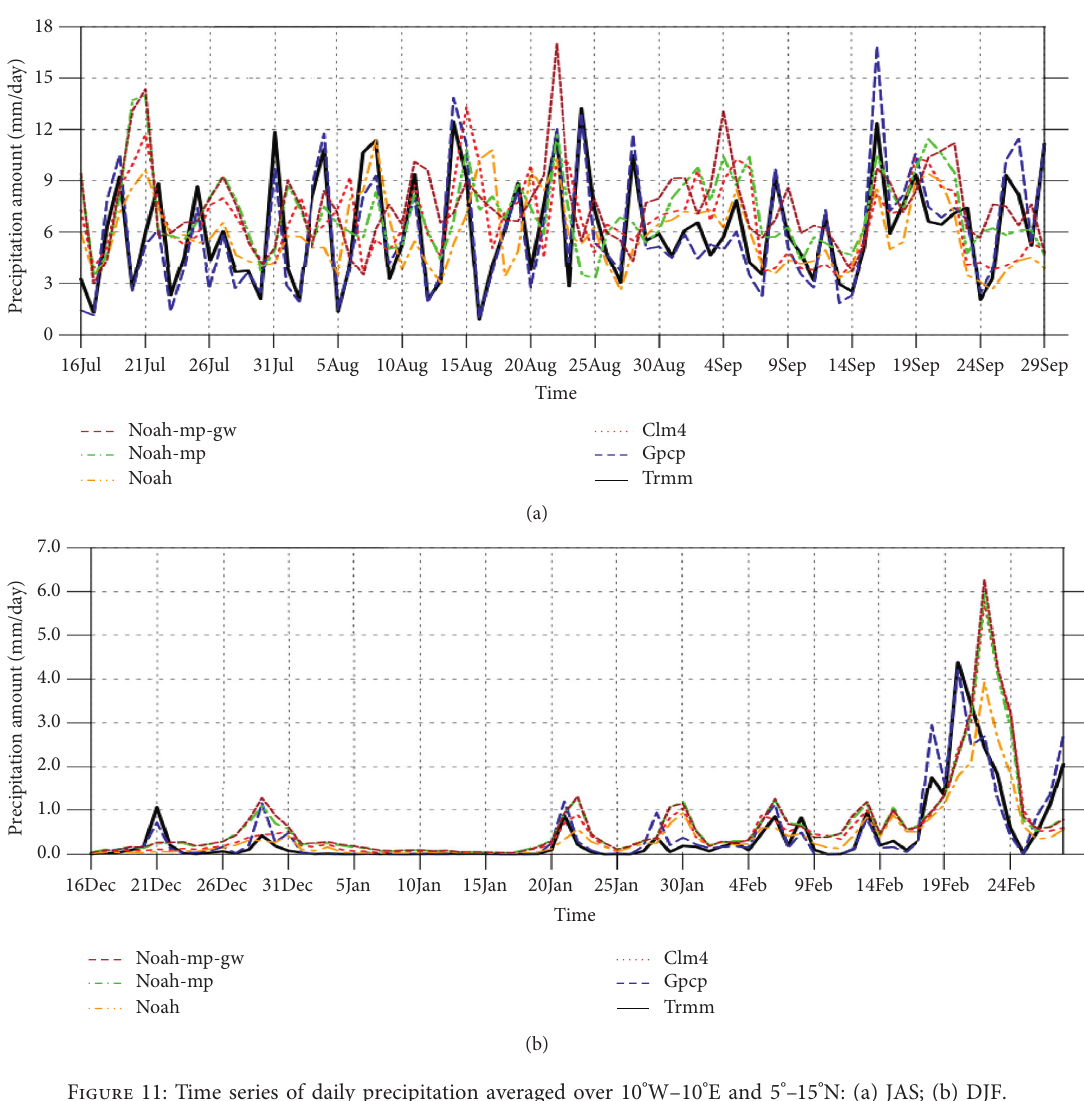
Figure 11: Time series of daily precipitation averaged over 10 ° W–10 ° E and 5 ° –15 ° N: (a) JAS; (b) DJF.